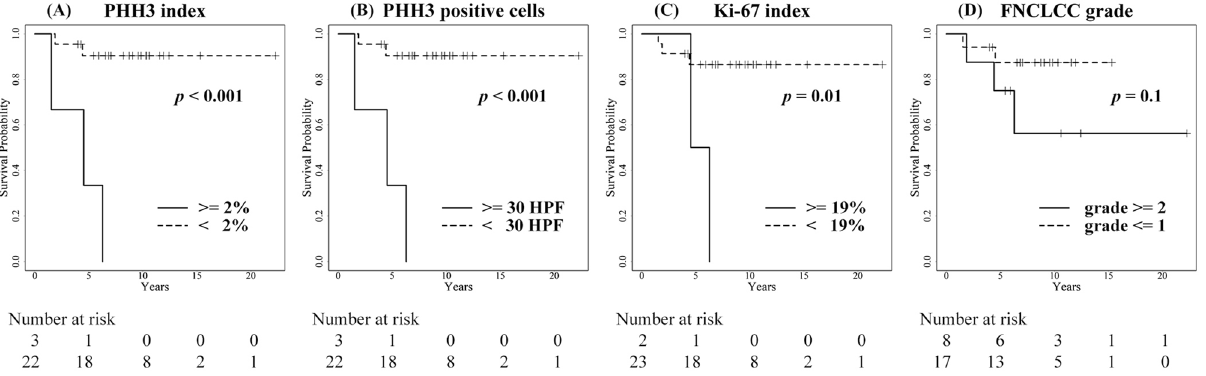
Figure 3. Kaplan–Meier curves of DSS in ( A ) PHH3 index, ( B ) number of PHH3 positive tumor cells, ( C ) Ki-67 index, and ( D ) FNCLCC grade. P -values are calculated by Log-rank test.